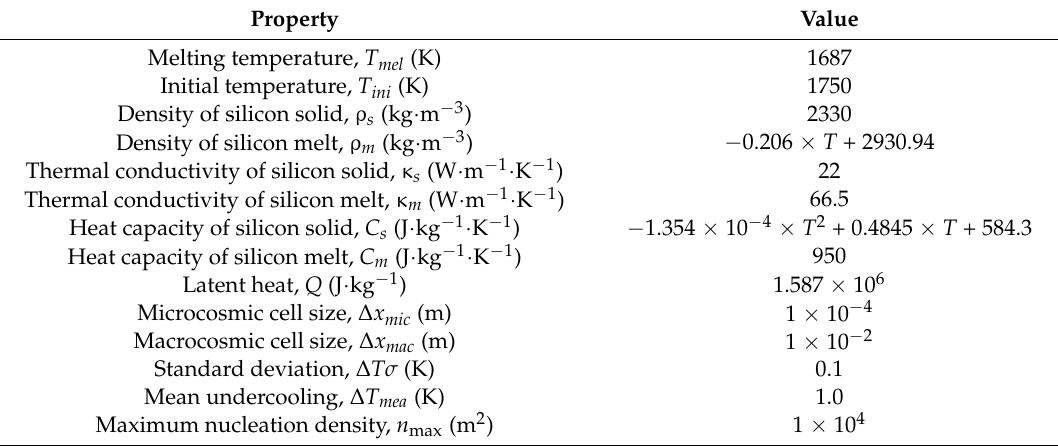
Table 1. Physical properties and calculation parameters used in the present